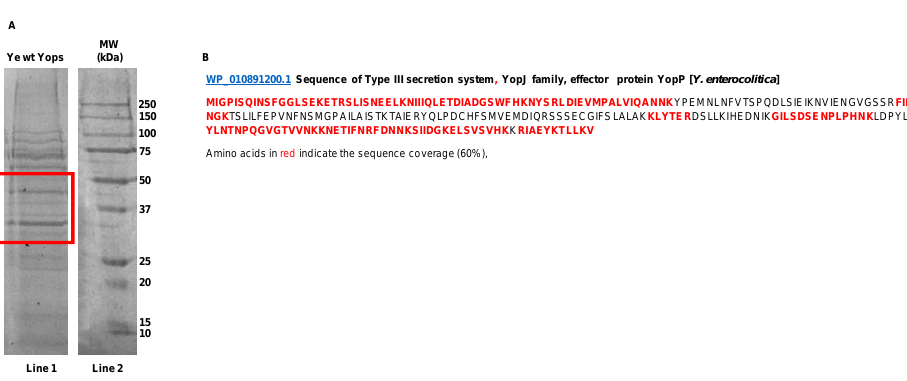
Figure 3. Protein bands derived from Yops selected for MS/MS analysis.Yops were solved in 1D- SDS-PAGE gels and stained with Coomassie Blue G-250 ( A , Lane 1). Molecular weight markers (MW) are shown in ( A ), Lane 2. The red squares indicate bands subjected to identification through MS/MS analysis. YopP peptides identified (highlighted in red) in the selected bands and protein coverage map of Type III secretion system YopJ family effectors are shown in ( B ). Table 2. YopP peptides identified through nLC-MS/MS